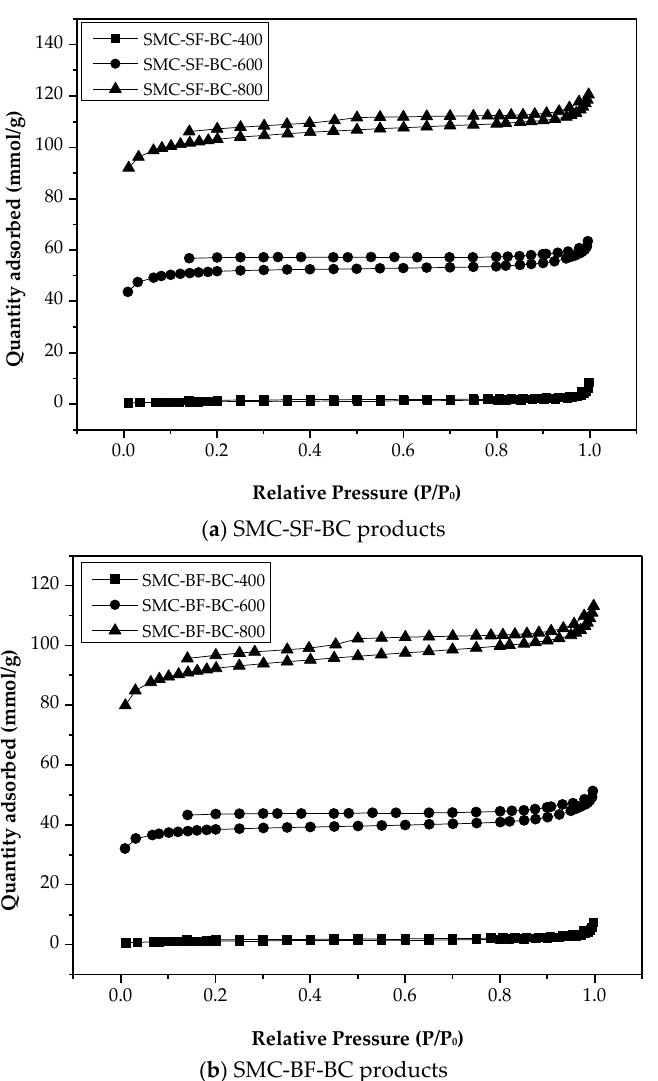
Figure 3. N 2 adsorption-desorption isotherms of ( a ) SMC-SF-BC products and ( b ) SMC-BF-BC products.